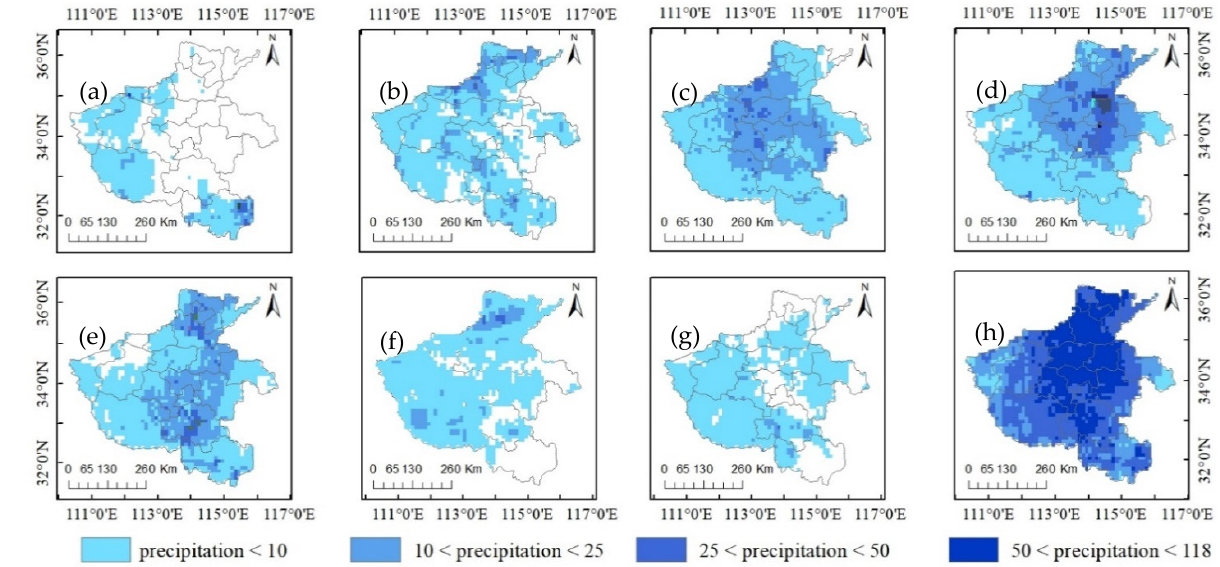
Figure 6. The daily precipitation and cumulative precipitation result. ( a – g ) is the precipitation from 17 July 2021 to 23 July 2021, respectively. ( h ) is the cumulative precipitation.